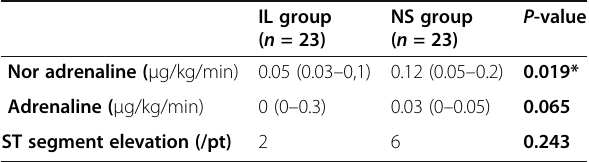
Table 3 Doses of inotropes used